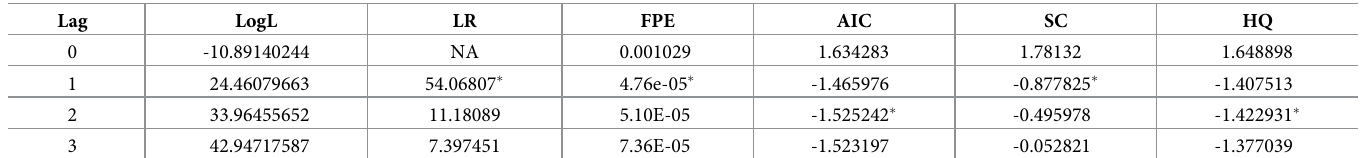
Table 6. VAR lag order selection